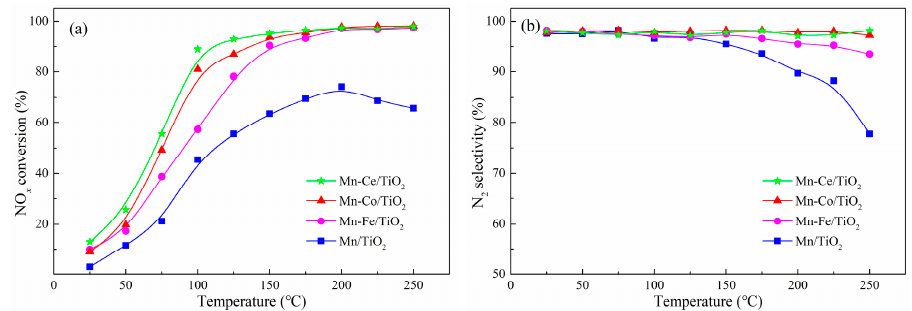
Figure 1. Catalytic performance of catalysts without plasma. Gas mixture composition: 300 ppm NO,